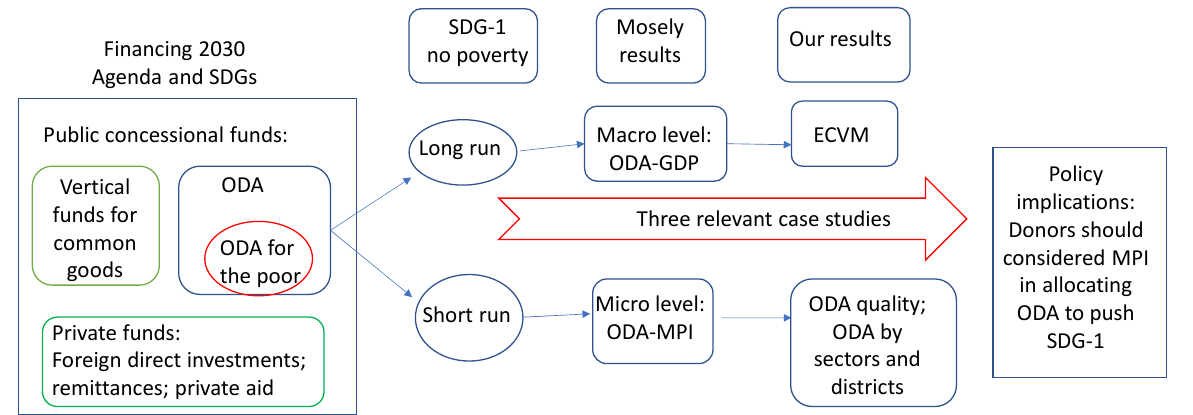
Figure 2. Research strategy. Author’s elaboration.